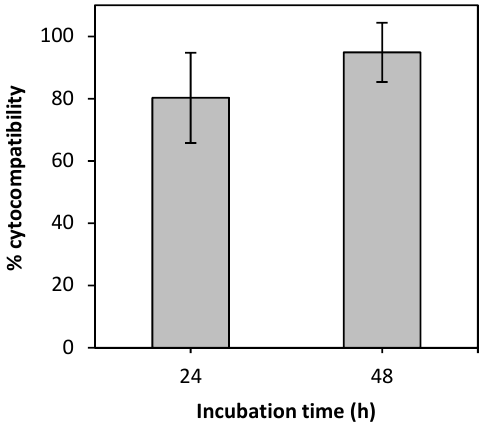
Figure 7. Cytocompatibility of the vancomycin ‐ loaded aerogel microparticles with BALB/3T3 mouse fibroblasts.